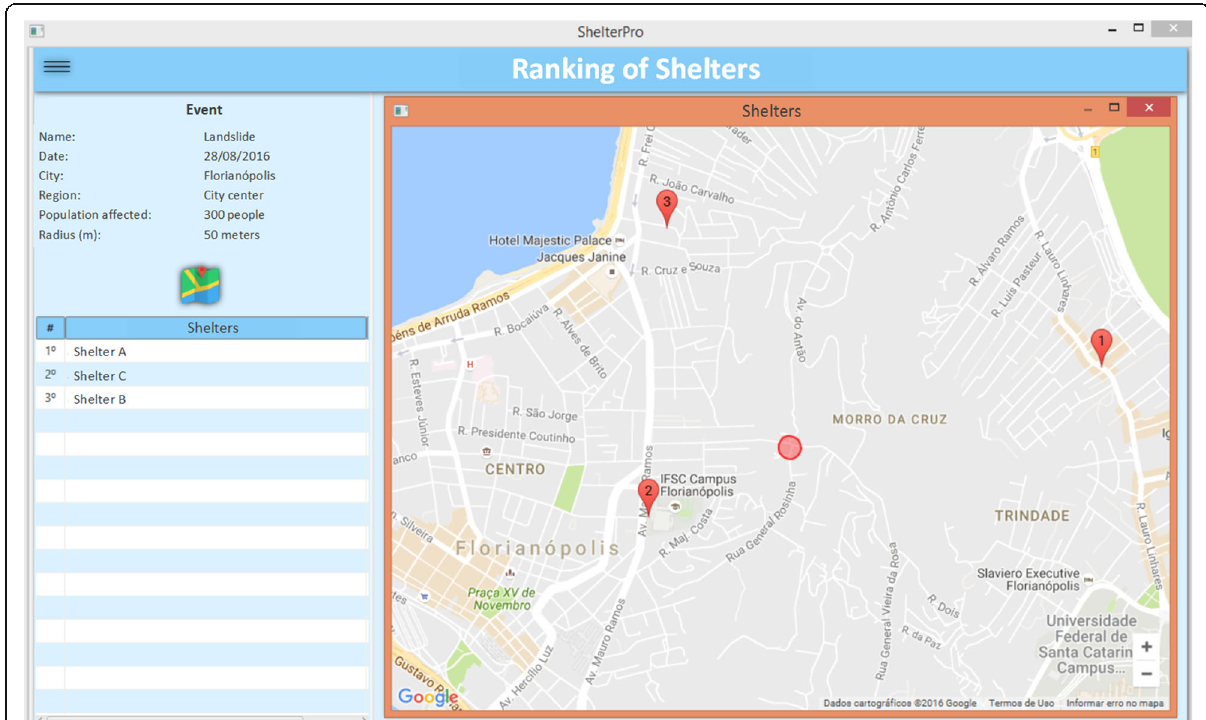
Fig. 9. ShelterPro ranking of best temporary shelters (after selecting an event)